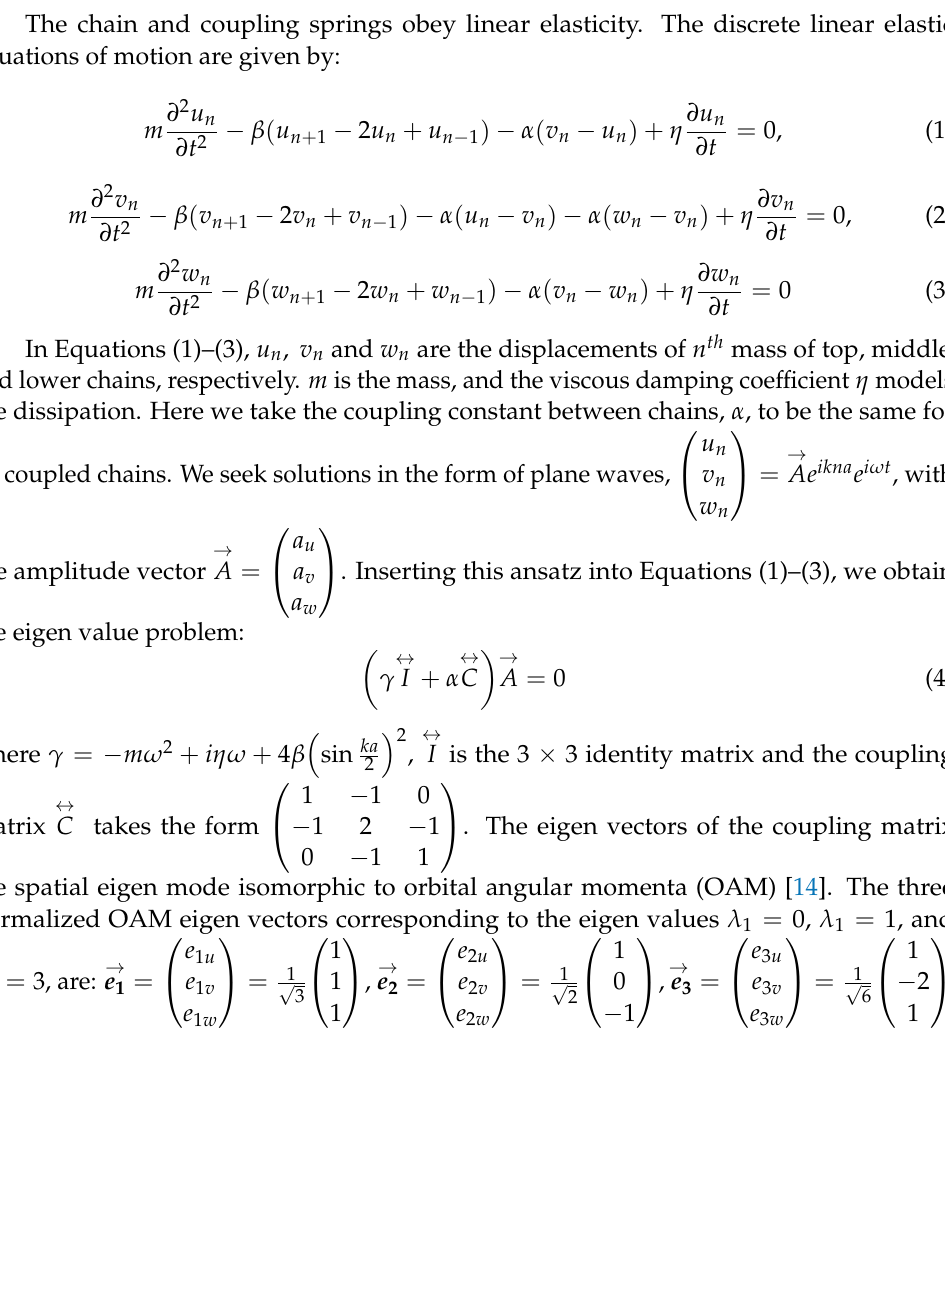
Figure 1. Schematic illustration of the system composed of three coupled one-dimensional elastic waveguides. The small springs couple the three elastic chains which masses are interacting via the large springs.